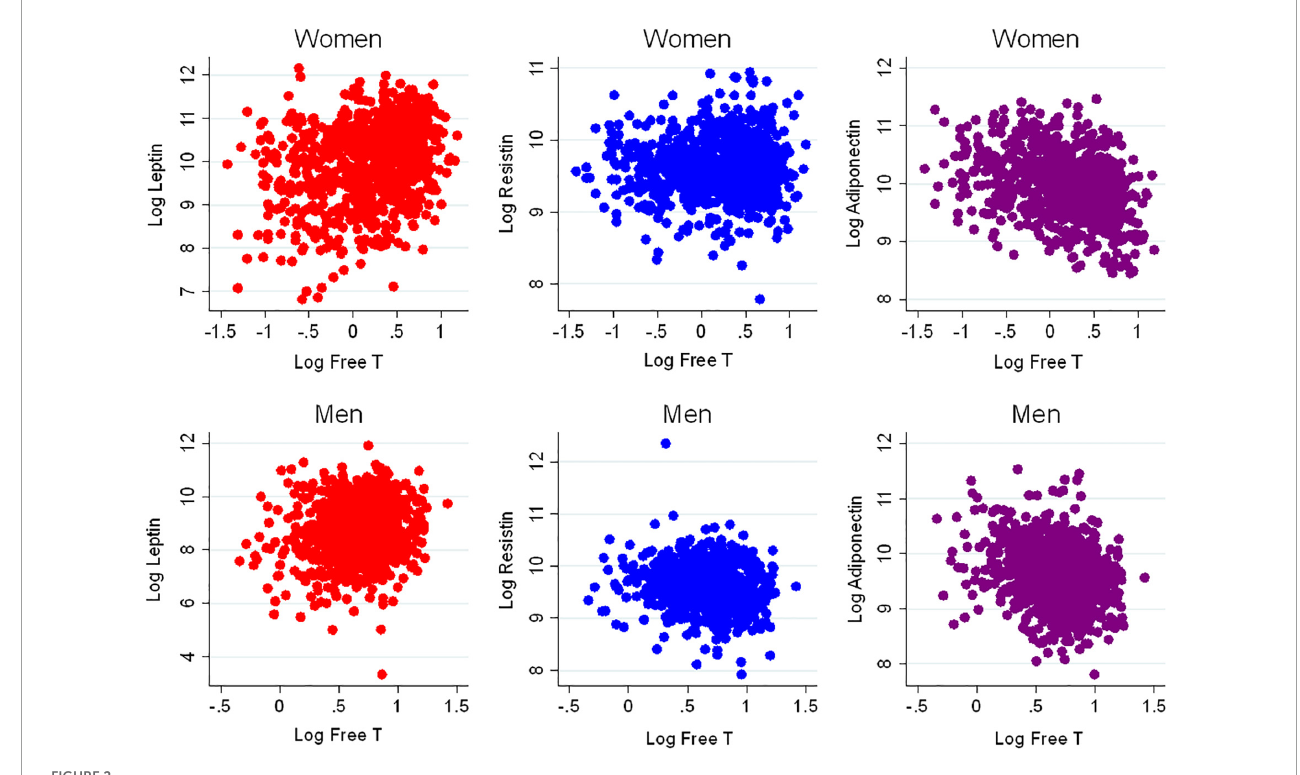
FIGURE2 Scatterplots of adipokines vs. free testosterone. T, Testosterone.